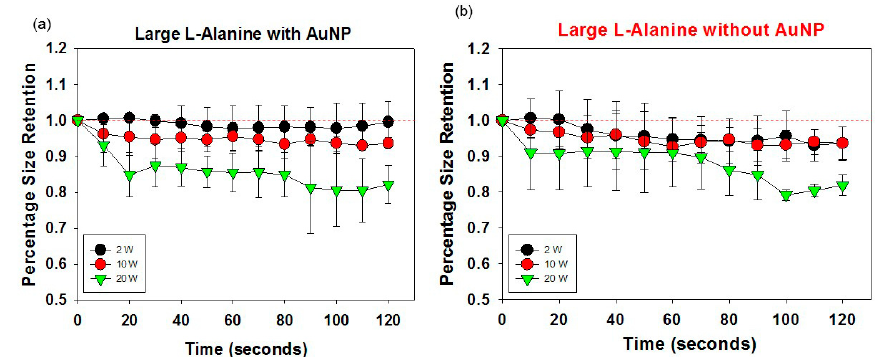
Figure 6. Normalized size retention rate of large L -alanine crystals (initial size = 4300 μ m) after 120 s of microwave heating ( a ) in the presence of gold nanoparticles and ( b ) in the absence of gold nanoparticles (control).